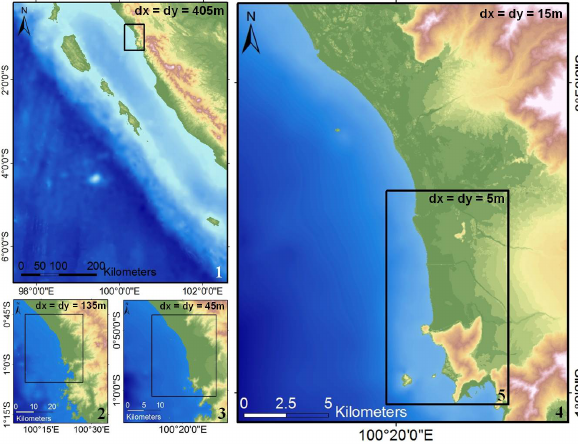
Fig. 2. Computational area from region 1 to 5 in a nested grid sys-